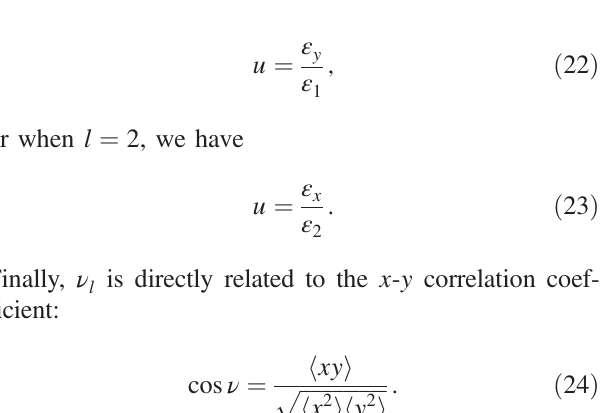
FIG. 5. Envelope of the Danilov distribution in real space at the entrance of a lattice with a tune split of 0.01. The horizontal and vertical phase space projections of the envelope are matched to the lattice.